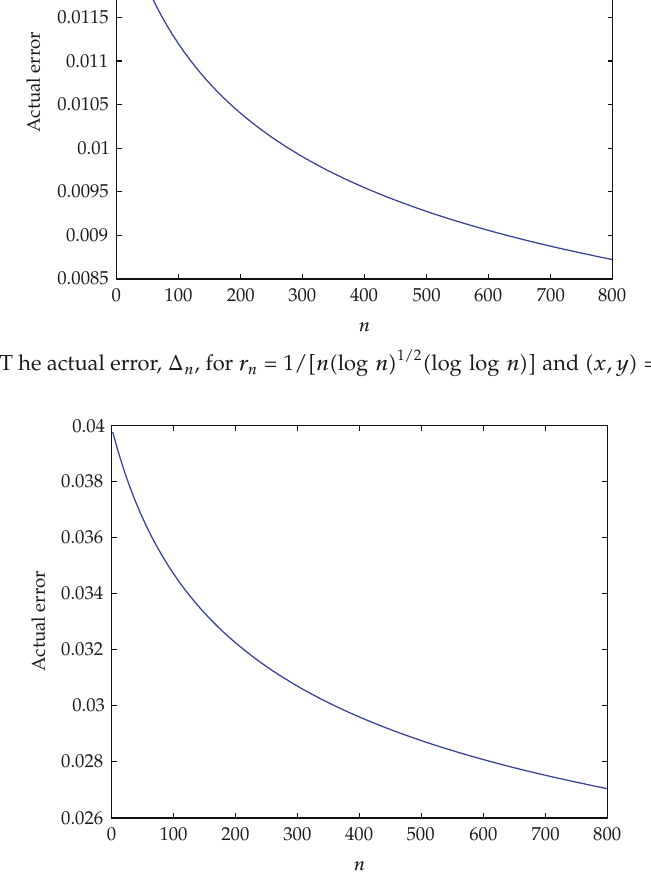
Figure 2: T he actual error, Δ n , for r n (cid:4) 1 / (cid:5) n (cid:2) log n (cid:3) 1 / 2 (cid:2) log log n (cid:3)(cid:6) and (cid:2) x,y (cid:3) (cid:4) (cid:2) 0 , 0 (cid:3)